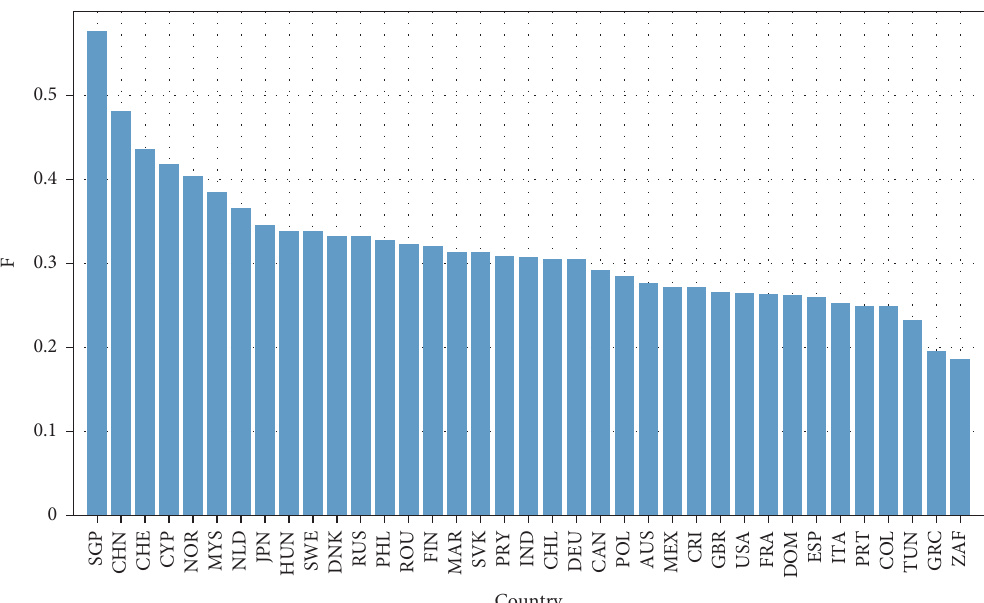
Figure 4: Final resilience scores for each